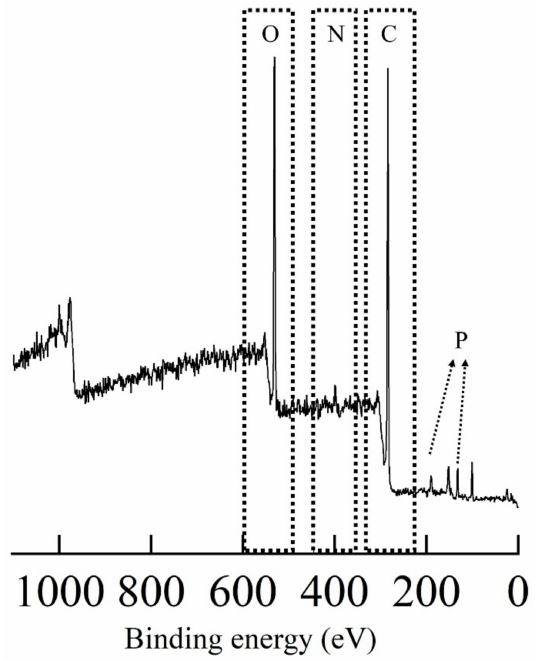
Figure 6. XPS spectrum of the